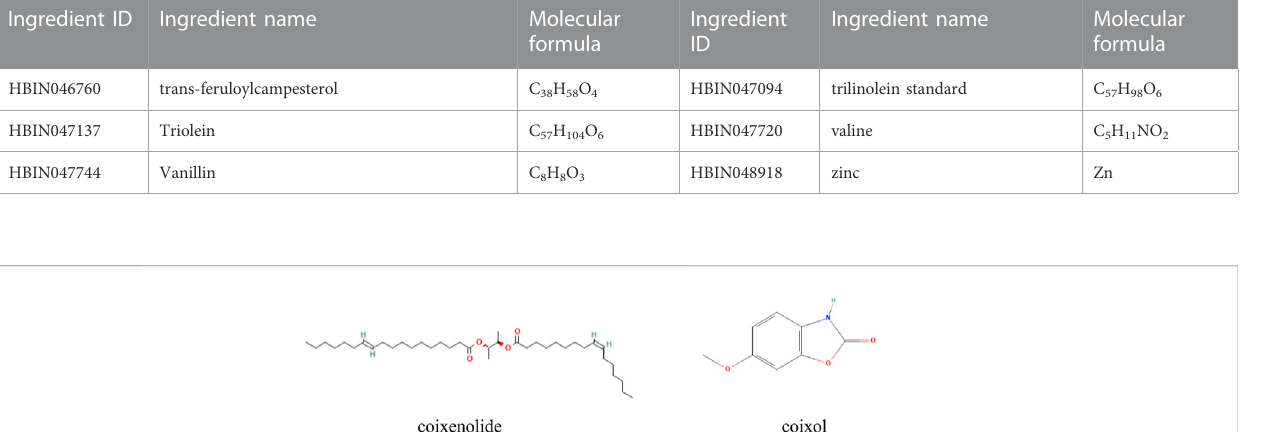
Figure 2. The extraction of various compounds from Coicis Semen laid the foundation for the in-depth study of the pharmacological mechanism through which the botanical drug exerts anti-tumor effects via multiple targets and pathways. Coix seed oil, as an effective extract of Coicis Semen , is mainly composed of neutral oil, including ester compounds and fatty acids.